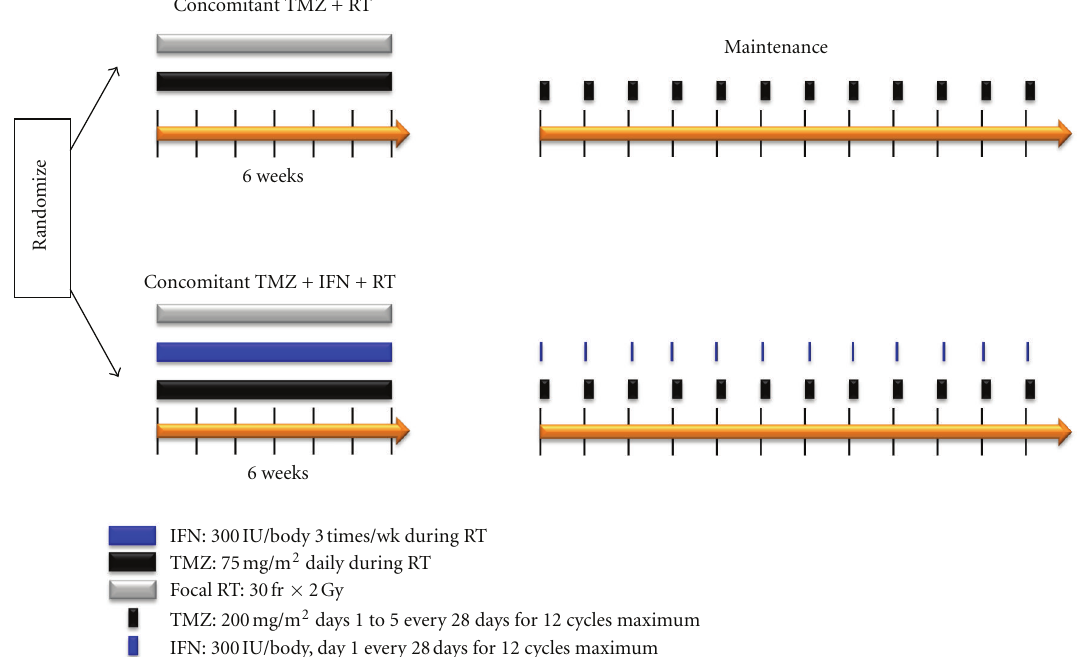
Figure 3: Combination with interferon- β : the JCOG0911 (INTEGRA) study. A randomized phase II clinical trial in patients with newly diagnosed GBM is under way to compare the standard-of-care regimen with the addition of IFN- β in the upfront